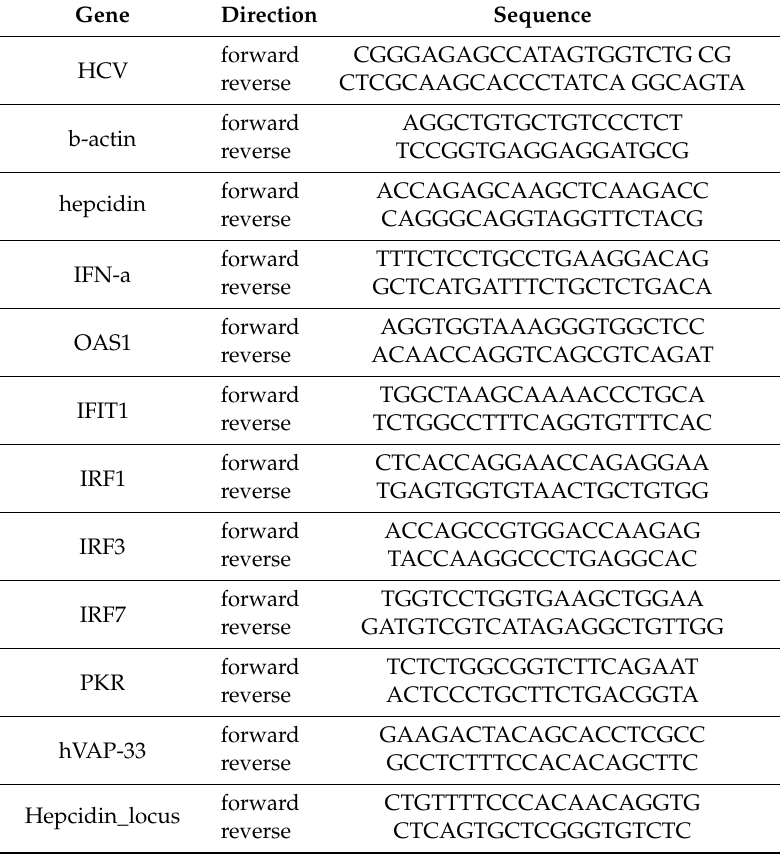
Table 1. List of primer couples generated for